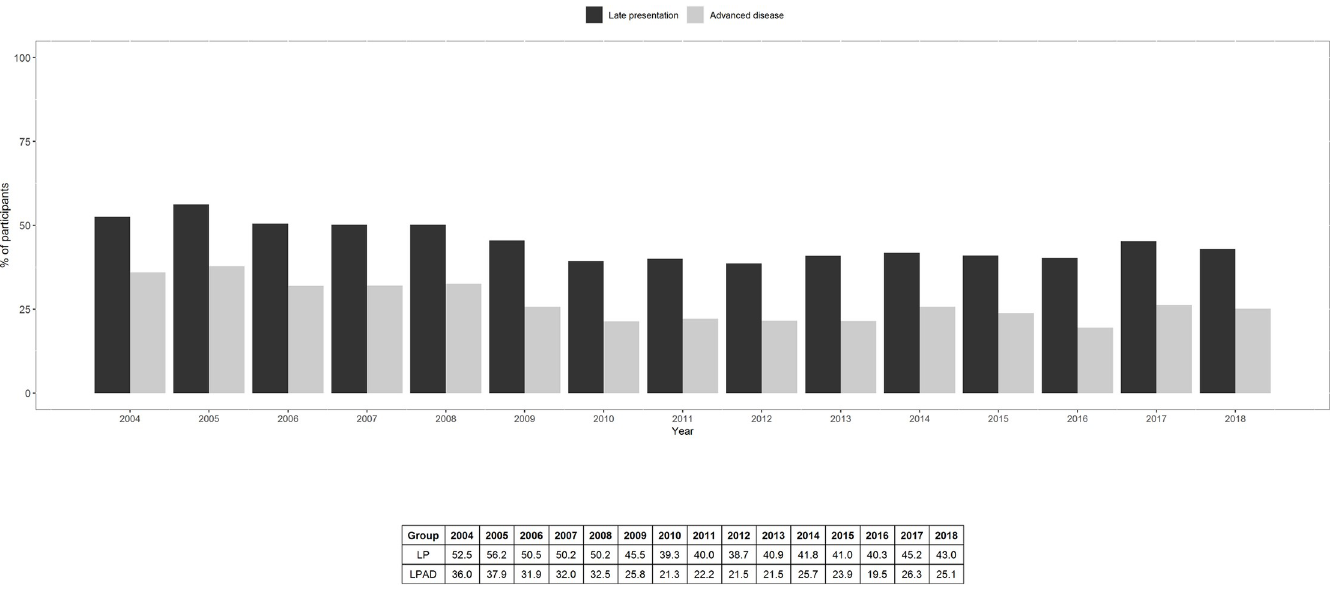
Fig 1. Annual prevalence of LP and LPAD,